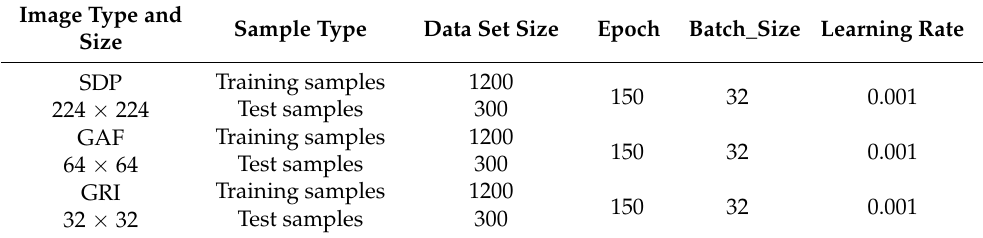
Table 3. Training parameters of VGG16